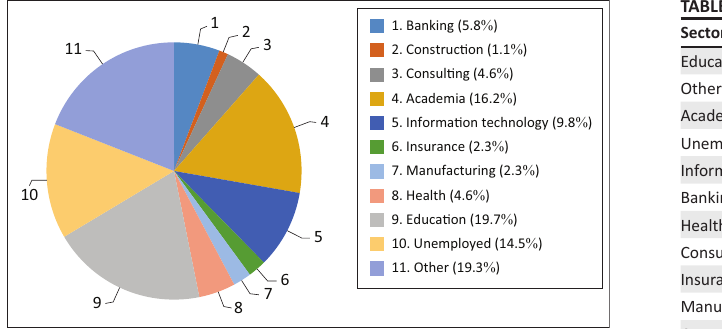
FIGURE 2: Sector or occupation analysis.